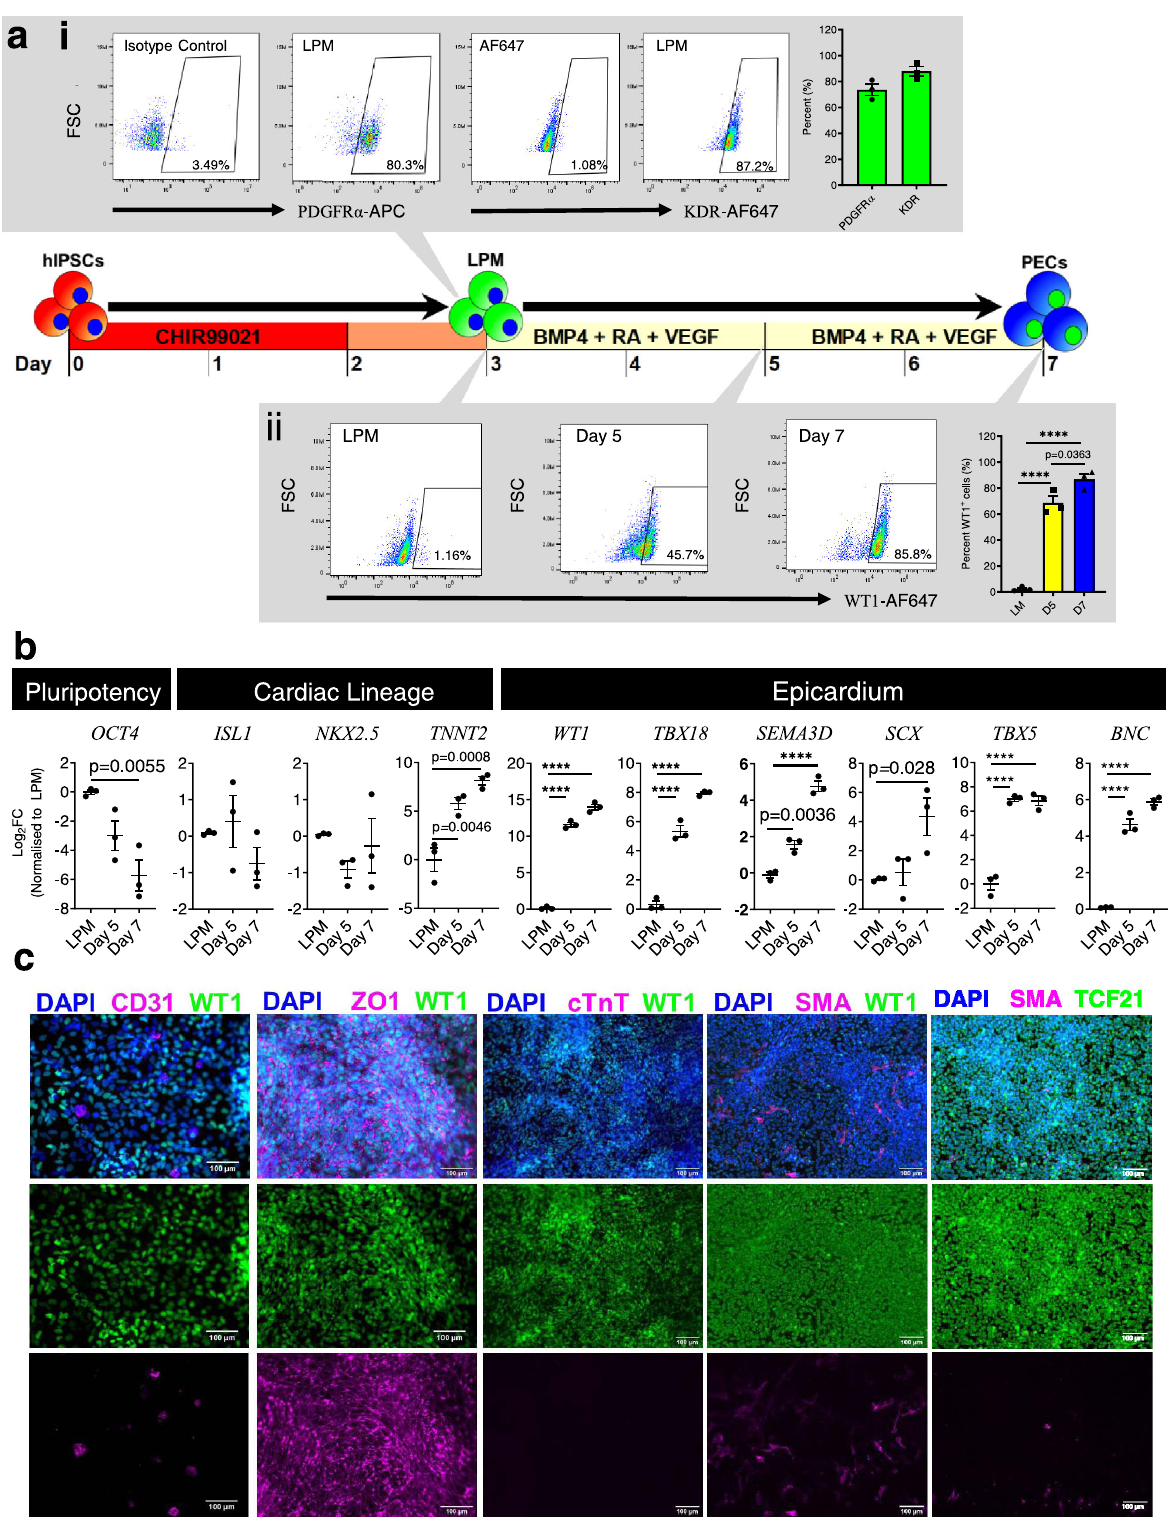
were enriched for angiogenesis, circulatory system development, and cell motility or migration (Fig. 2ci). This is in contrary to Epi P1 vs. Epi H9 of which the DEGs involved in the heart, mesenchyme, circulatory and nervous system development were upregulated, while the downregulated DEGs